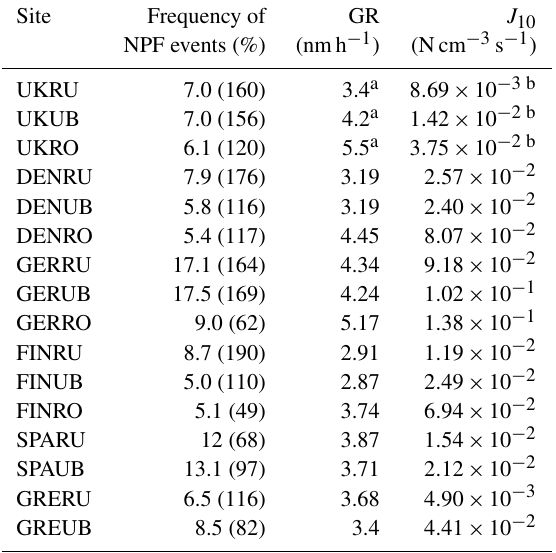
Table 2. Frequency (and number), growth, and formation rate of class Ia NPF events.